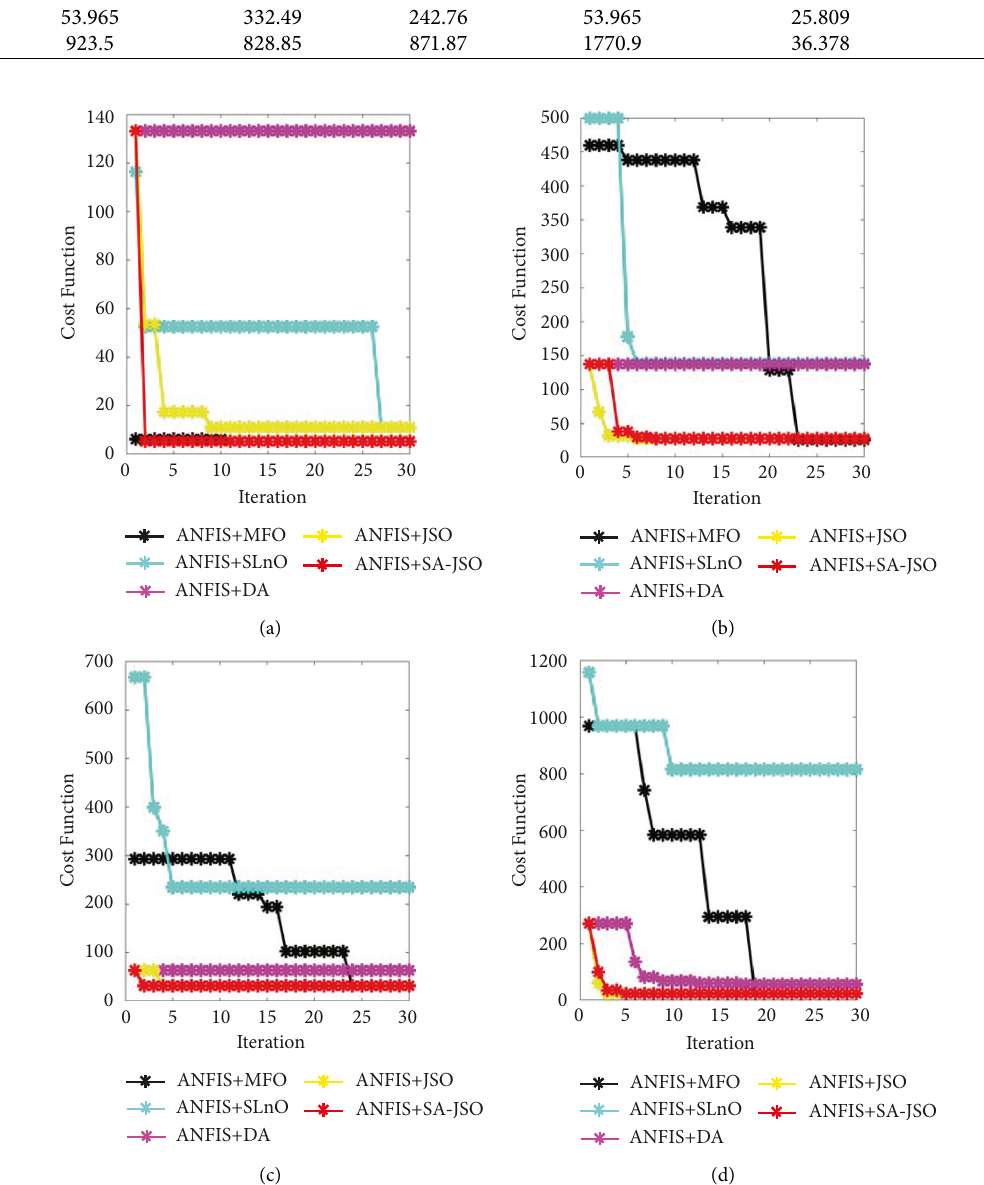
Figure 5: Convergence analysis of developed approach over compared approaches regarding group 1 scenario by fixing counts of nodes as (a) 100, (b) 250 (c) 750, and (d)